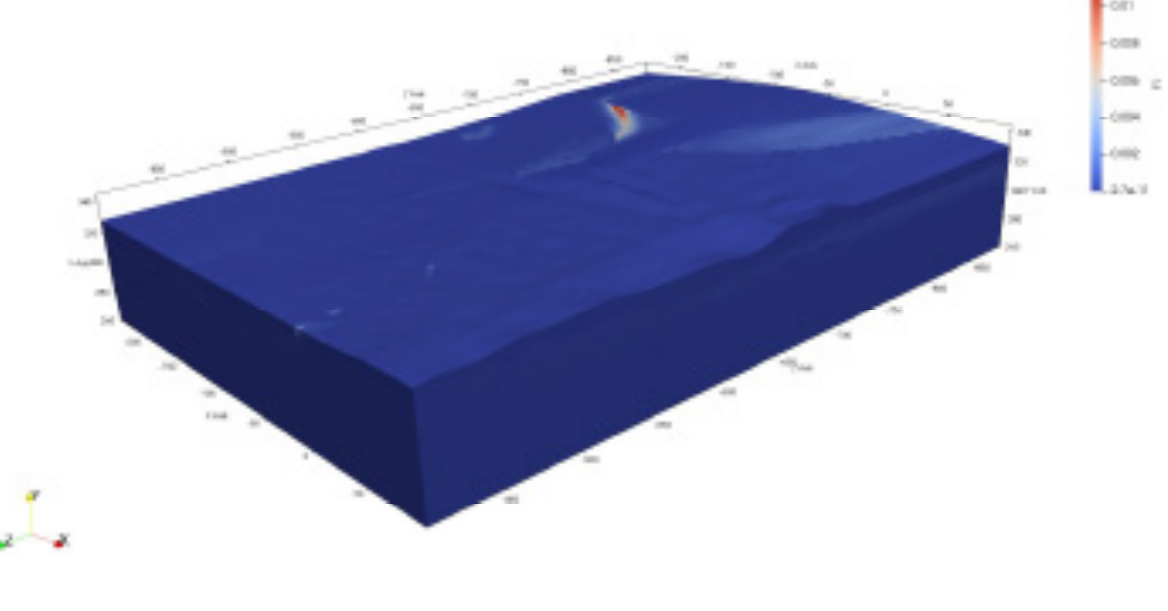
Figure 9: Distribution of the F